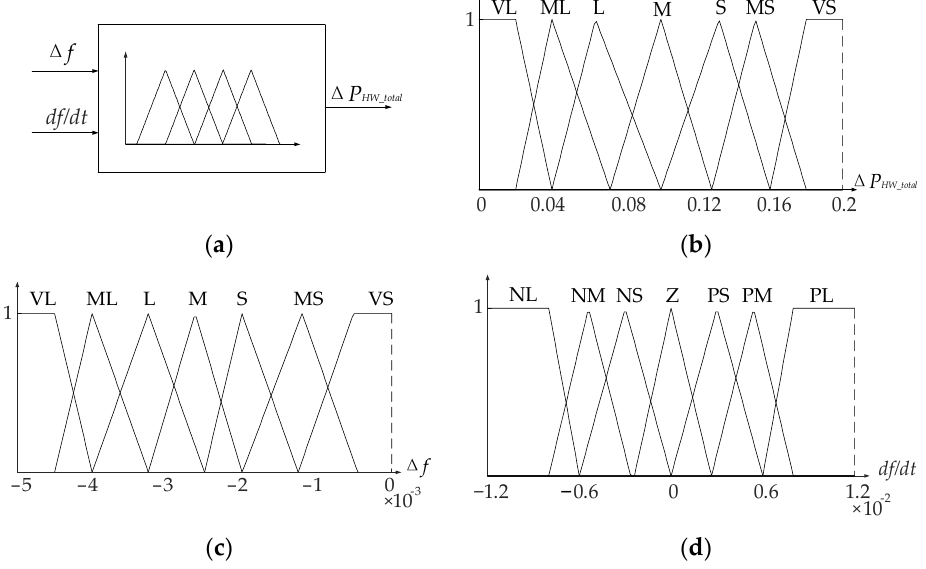
Figure 7. The structure diagram and membership of FLC-1. ( a ) The structure diagram of FLC-1, ( b ) the membership function of Δ P HW_total , ( c ) the membership function of Δ f , and ( d ) the membership function of df/dt .